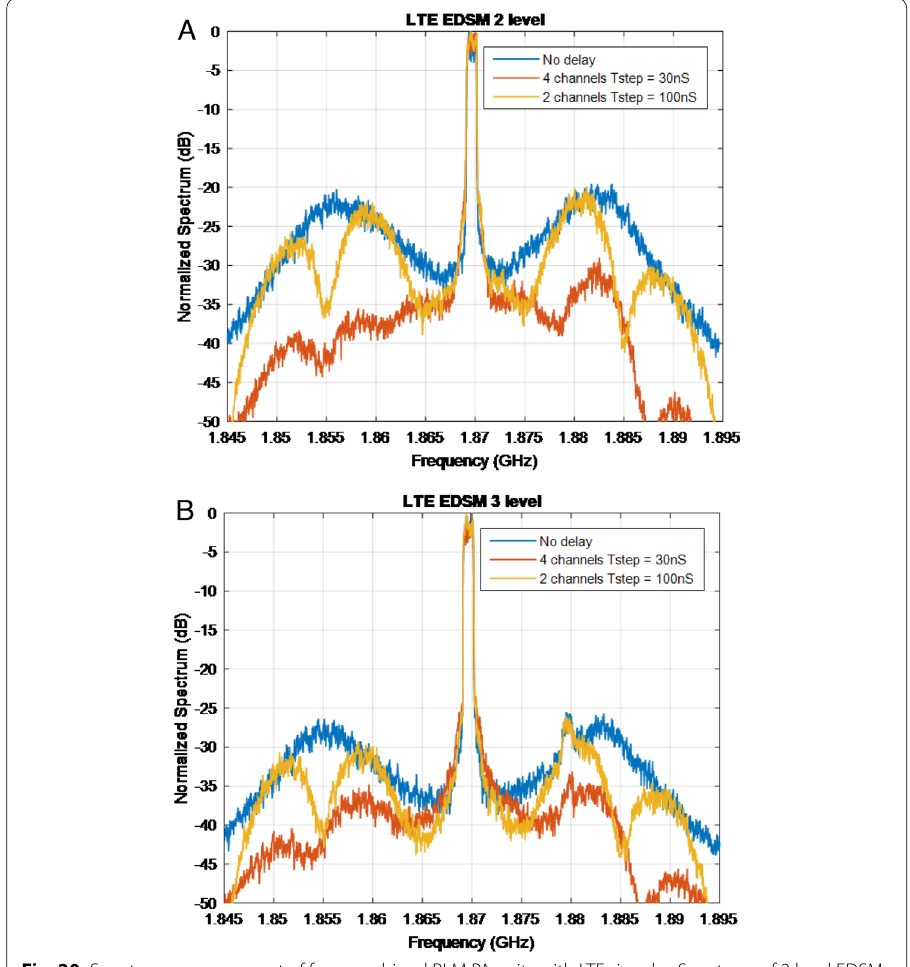
Table 4 Output power and drain efficiency (DE) of four PAs combining module EDSM level Noise suppression Pout (dBm) Efficiency SQNR (dB) In‑band LTE signal with PAPR of 10 dB 2